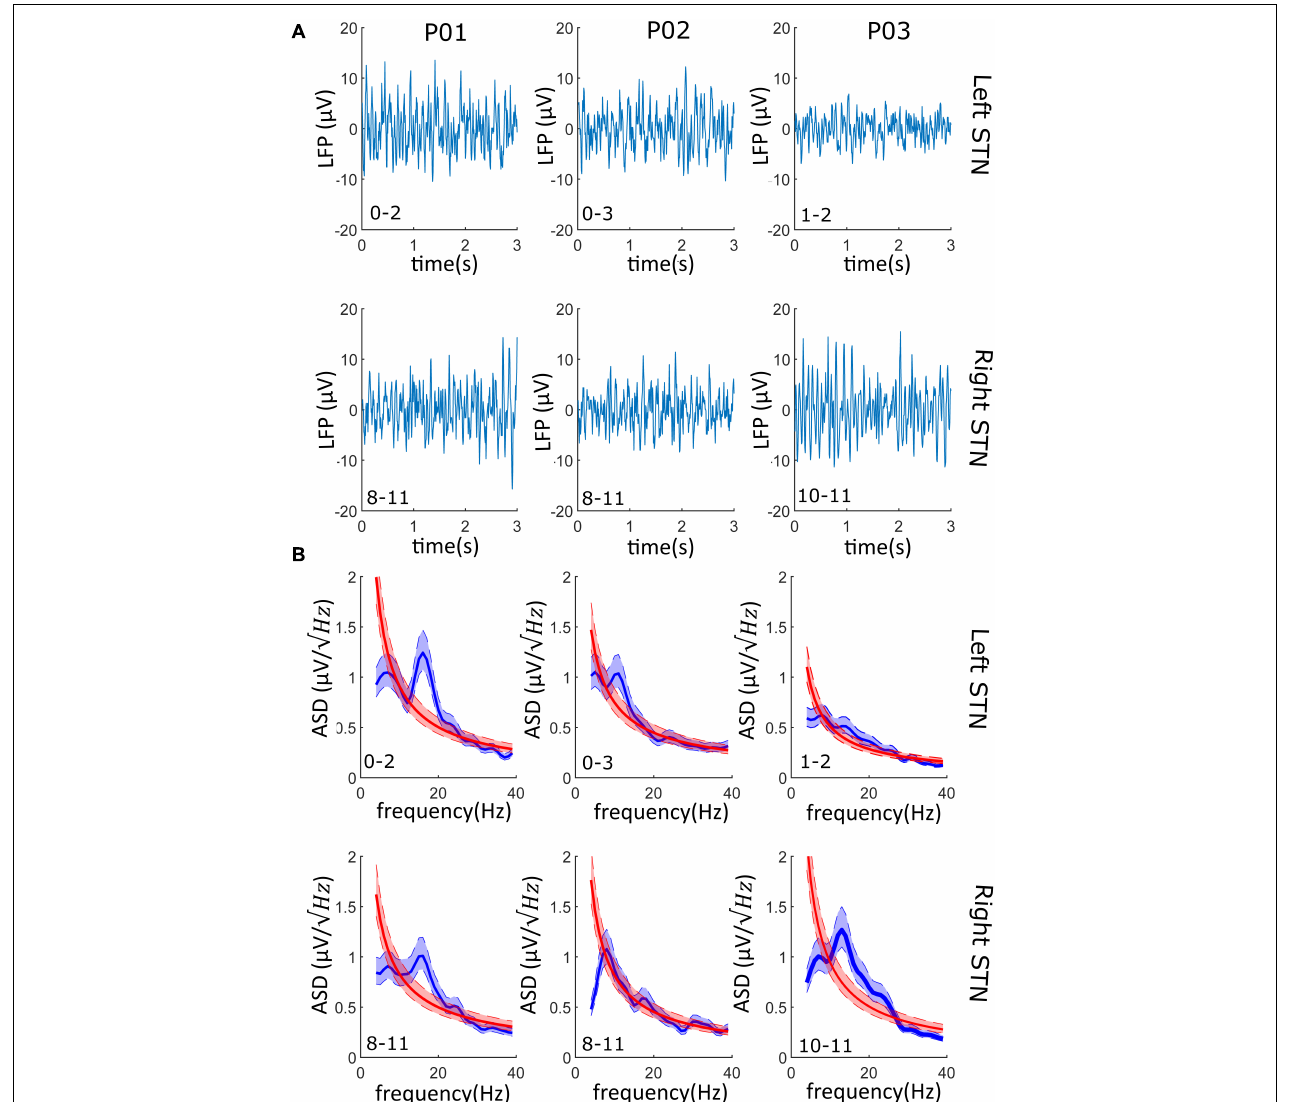
FIGURE 3 | LFPs from the streaming mode: (A) Left and right LFPs time series. 3–s LFPs recordings are shown for both the left and right STN of each patient; on the bottom left corner, the contact pair used for recording is reported (i.e., “0–2” and “8–11”). (B) The PSD of the LFPs recordings of panel (a) is shown (blue line) and superimposed to the PSD of the 1/f background noise (red line). 95% confidence interval is shadowed around the PSD average (lighter blue and lighter red overlapped band). In at least one side per patient (four of the six recordings), the beta oscillations have a significative higher power than the background neural